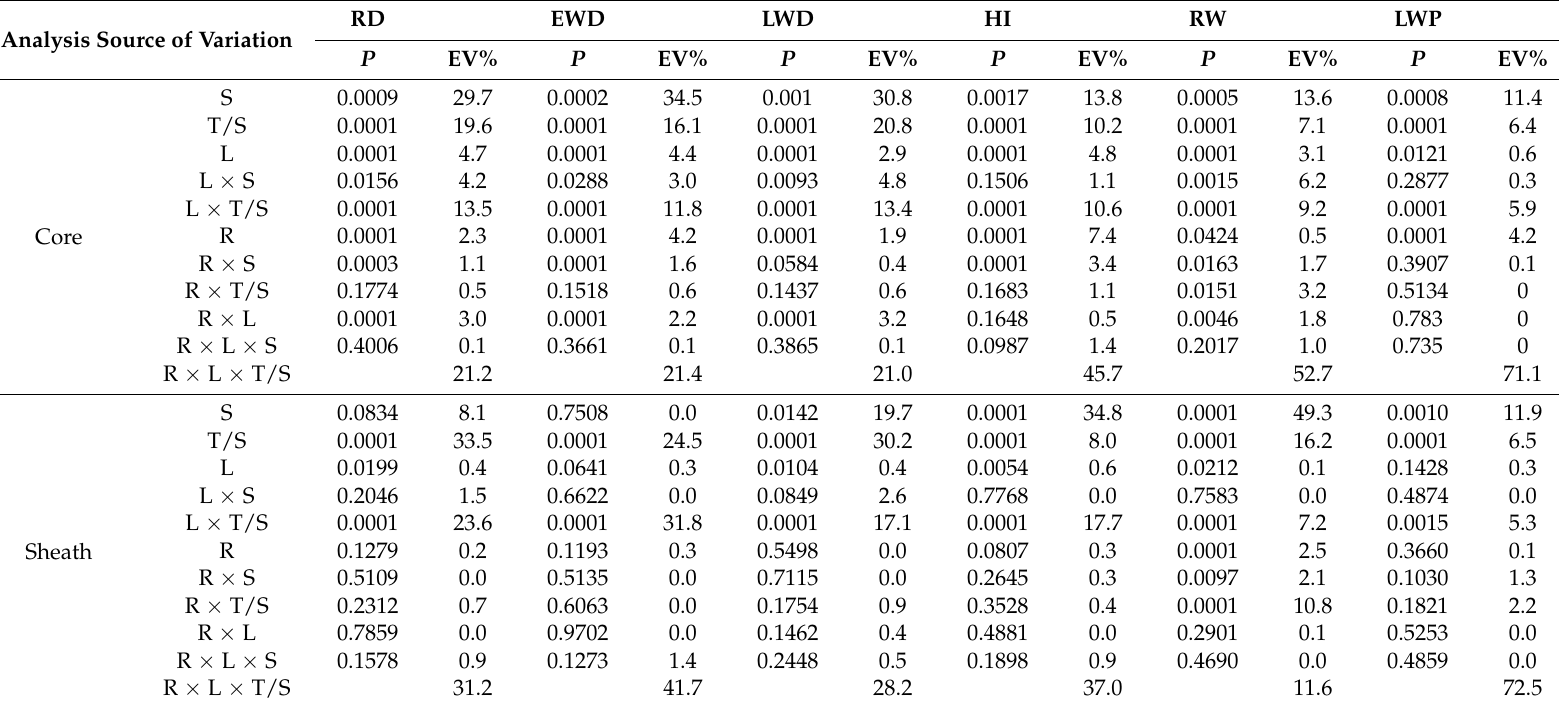
Table 4. Results of the core and sheath analysis of variance for the wood density and ring width components, showing their significance ( P values) and the expected variation (EV%, percentage of total variation due to each source of variation), at both sites (RD, ring density; EWD, earlywood density; LWD, latewood density; HI, heterogeneity index; RW, ring width; and LWP, latewood